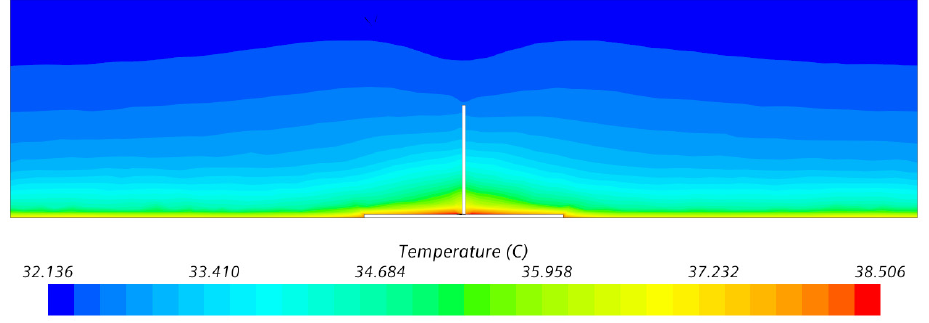
Figure 9. Visualization of façade temperature field—horizontal cross-section at height of 10 m summer extreme.